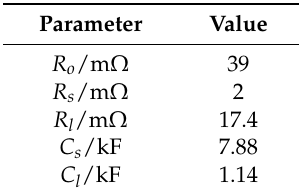
Table 3. Parameter identification results.